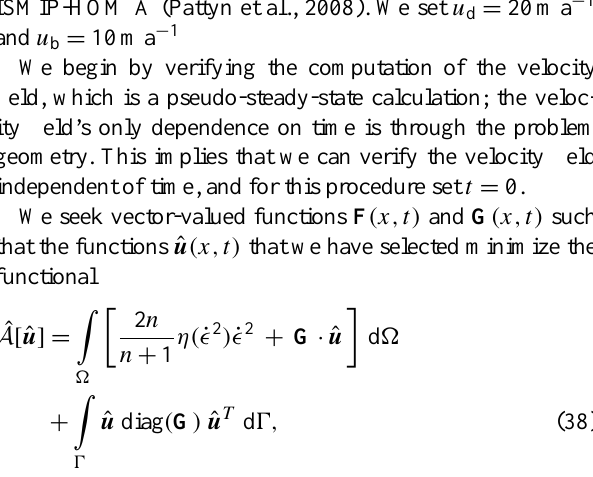
. 0 . 0 . 55 N Processors Fig. 2. Parallel efficiency computed for one complete Newton solve of the first-order equations for meshes with different degrees of freedom. All linear solves were performed using parallel GMRES (generalized minimal residual method) preconditioned with Hypre-